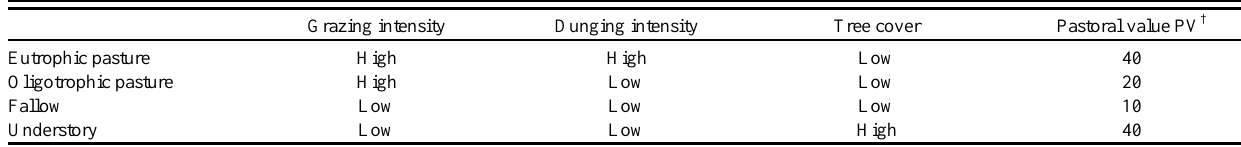
Table 1 . Vegetation types of the herb layer and simulated environmental factors under which they emerge, as well as their pastoral value, from which a first estimate of biomass production is calculated. Grazing intensity Dunging intensity Tree cover Pastoral value PV † Eutrophic pasture High High Low 40 Oligotrophic pasture High Low Low 20 Fallow Low Low Low 10 Understory Low Low High 40 † The pastoral value is based on vegetation surveys (Gillet and Gallandat 1996, Gillet 2002, 2008), except for understory. Here PV is artificially set to the value of eutrophic pasture, because the lower productivity of understory is expressed by a combined influence of drought and tree cover (see